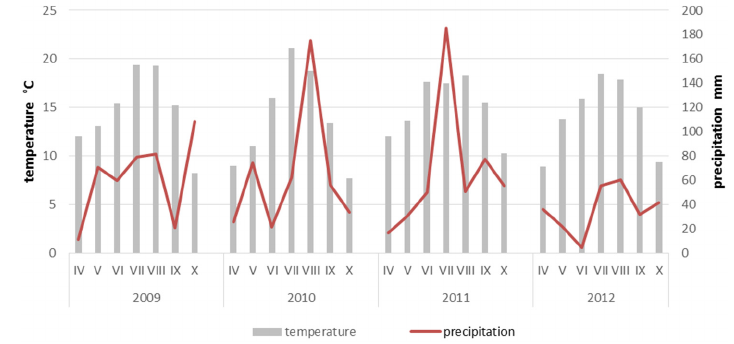
Figure 2. Monthly values of mean air temperature and sum of precipitation (according to [33]).